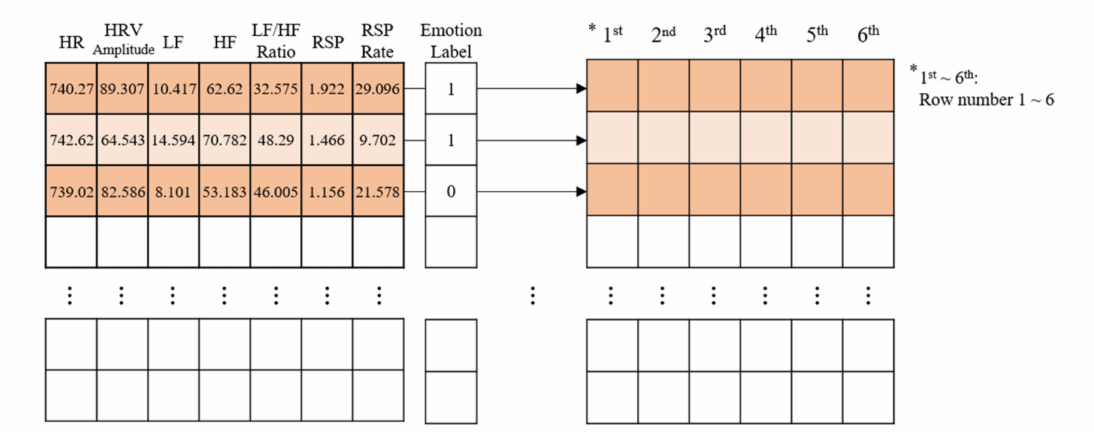
Figure 7. Method of processing input data of the CNN model constructed in this